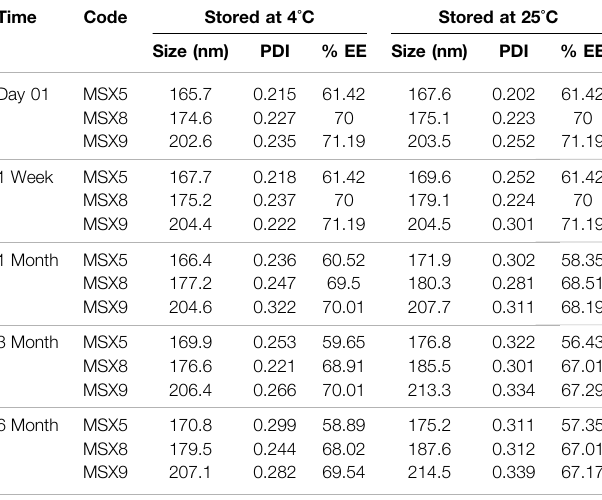
TABLE 8 | Results of stability studies of methotrexate nanoparticles. Time